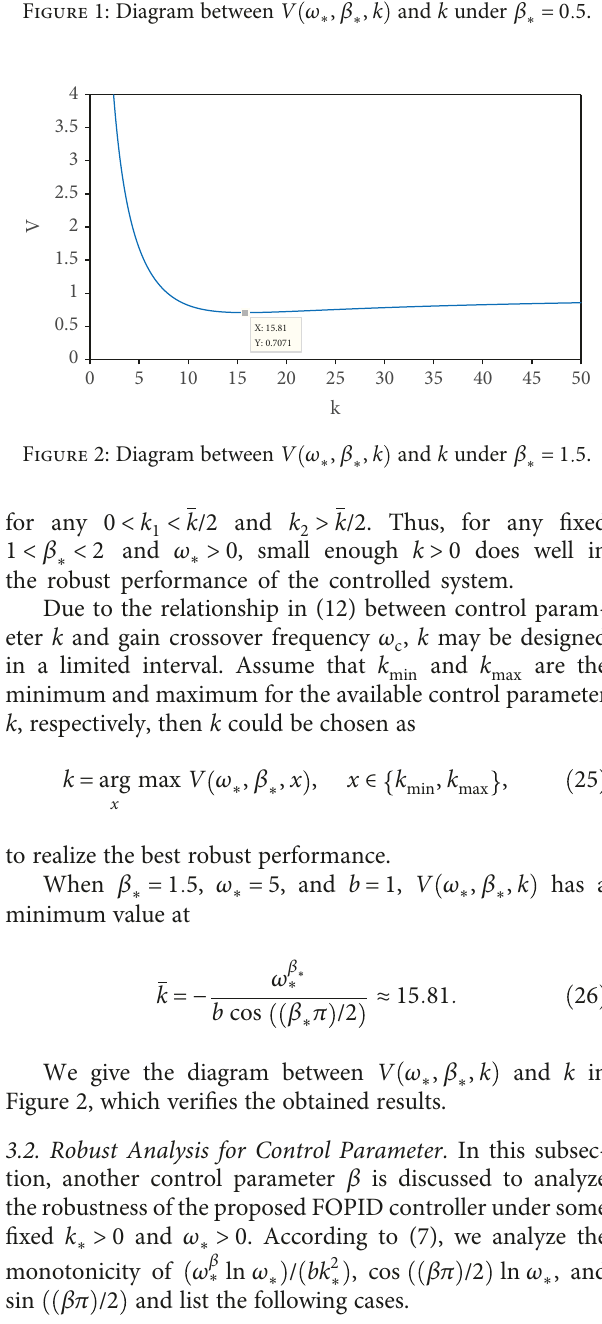
Figure 1: Diagram between V ω